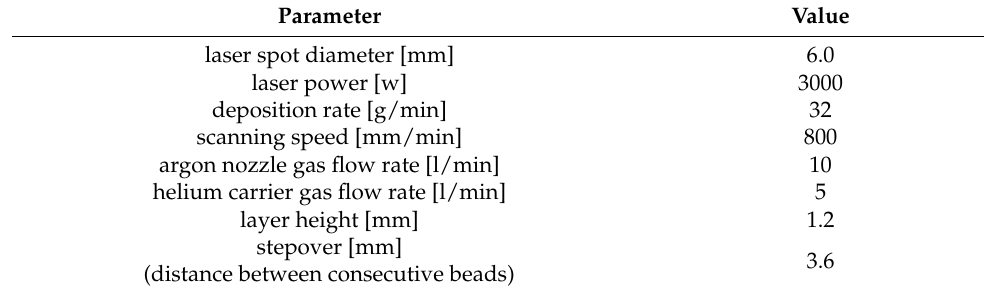
Table 2. Process